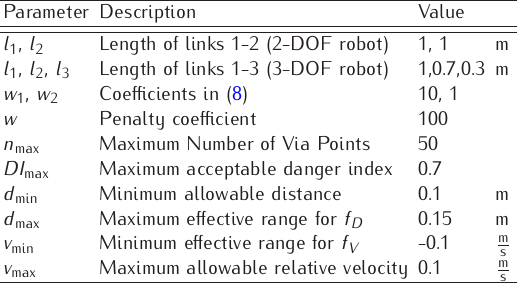
Table 1. System Parameters.